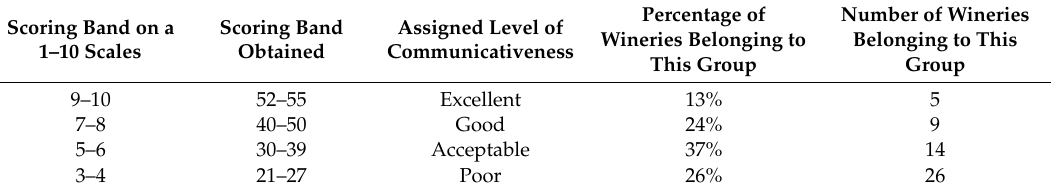
Table 5. Evaluation of websites of wineries in Mount Etna made by focus group 2.